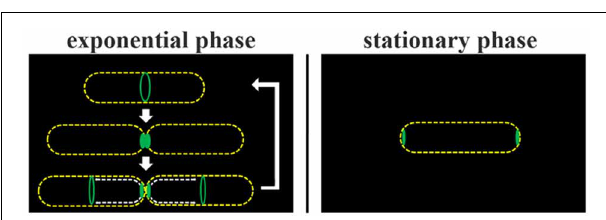
arrow). A cartoon of the photoconversion is shown. The relative fluorescence of the left pole (black circle), the right pole (blue circle), and the new formed septa (red arrow) was measured. The relative fluorescence of the corresponding spots were calculated (CTF was calculated and the highest CTF of each spot was set as 1) and plotted. For every time point spots were chosen individually. Heat maps and corresponding histograms are shown below.